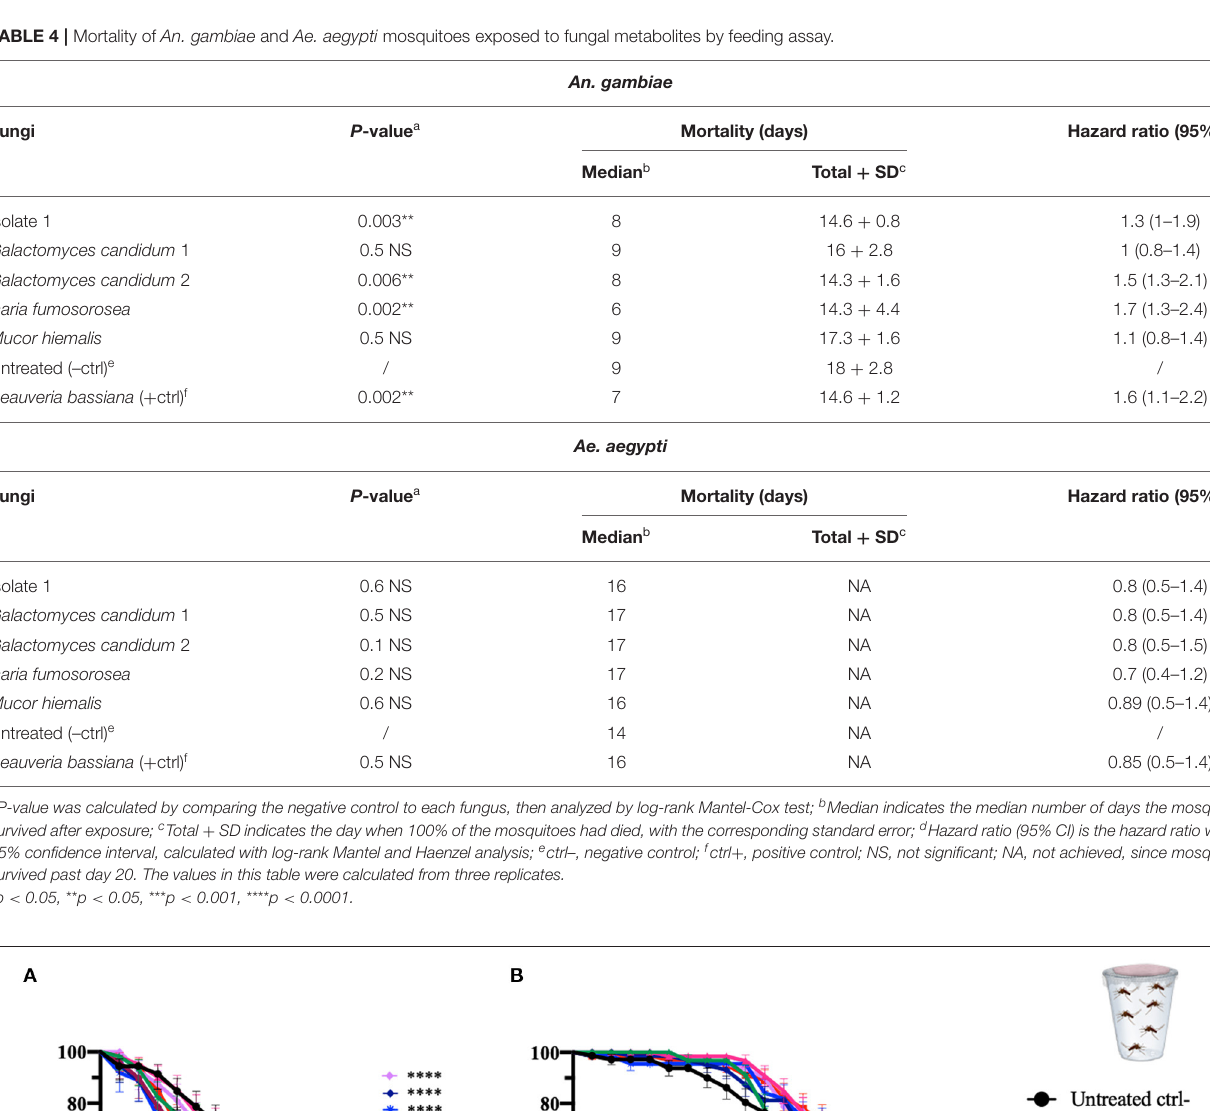
Frontiers in Fungal Biology |